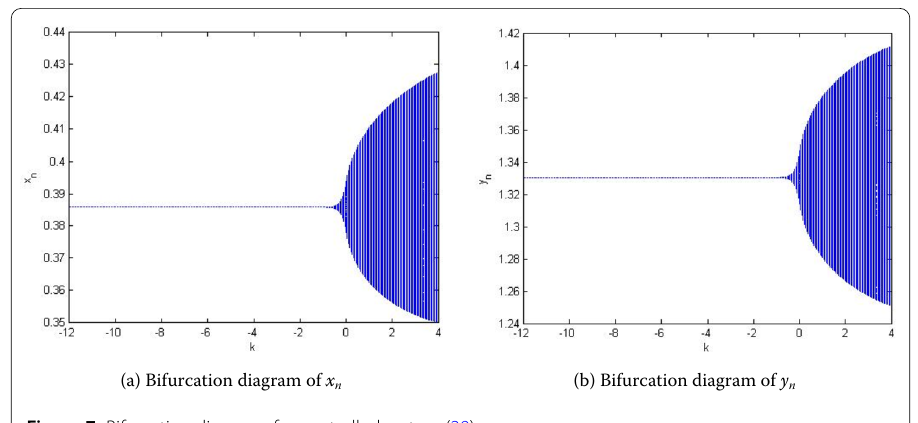
Figure 7 Bifurcation diagrams for controlled system